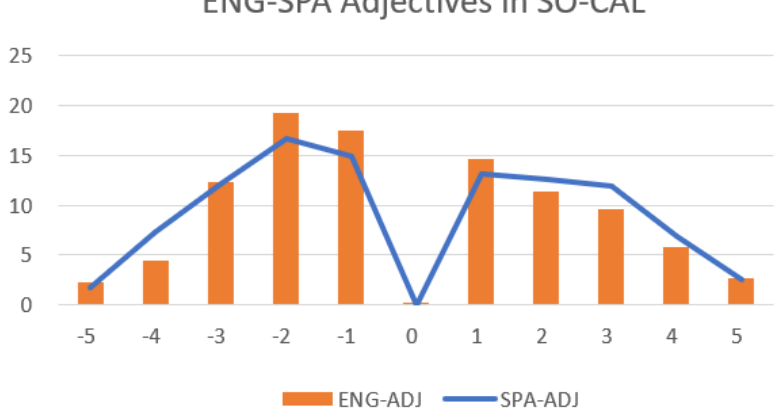
Figure 6. SO-CAL Adjectives by